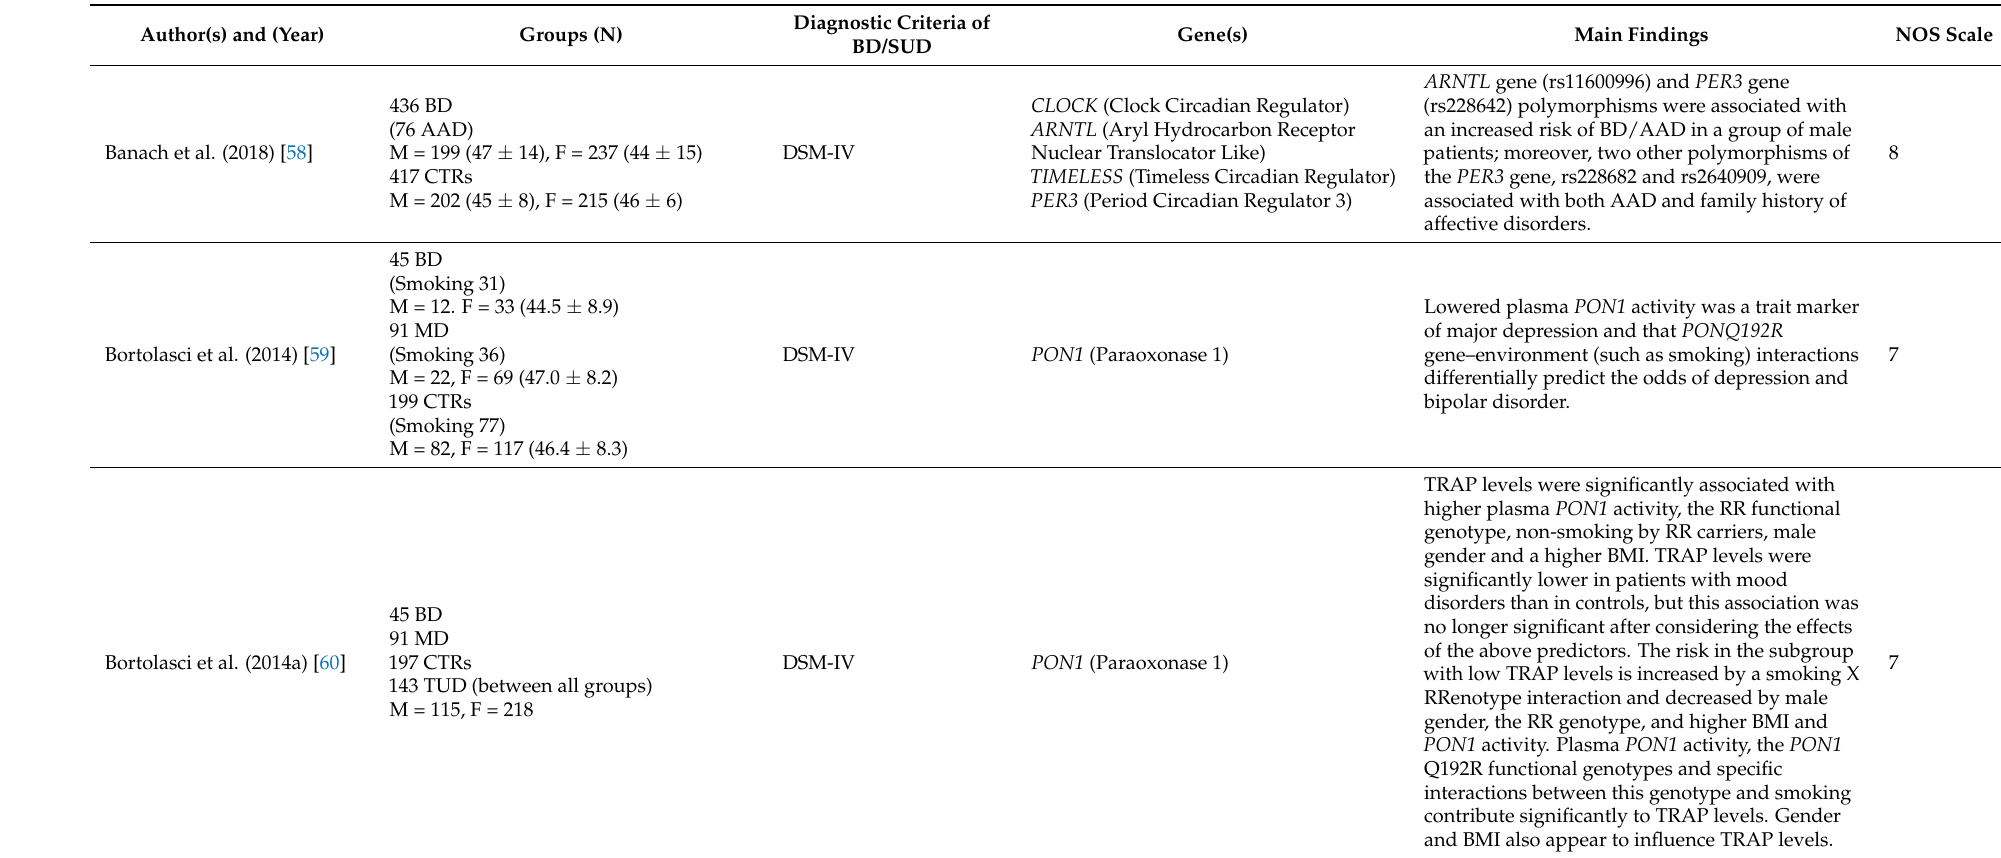
Table 1. The present table reports, in alphabetical order, the most relevant information of each eligible selected publication (NA = not